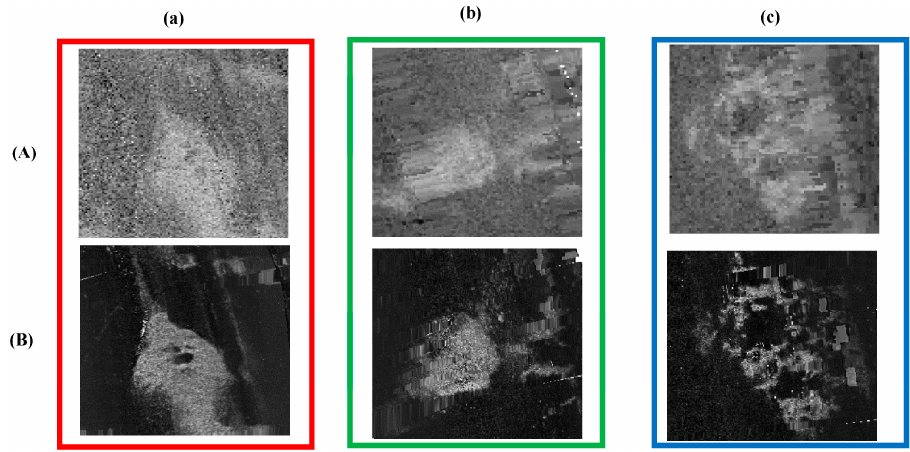
Figure 13 . Comparison of two types of superimpositions. ( A , B ) denote the superimposition shown in